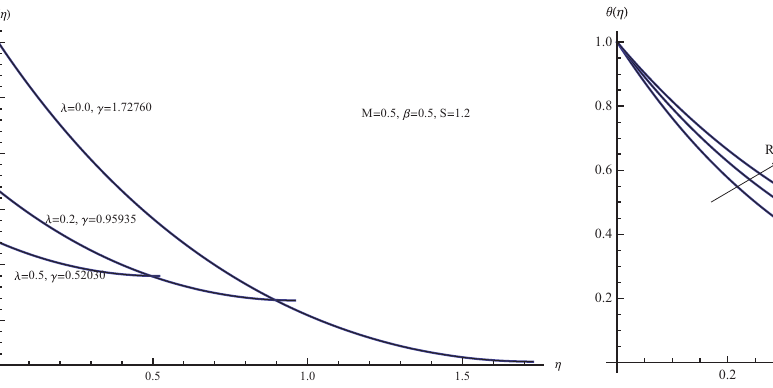
Figure 11: ( ) f η ′ for assorted quantities of λ .